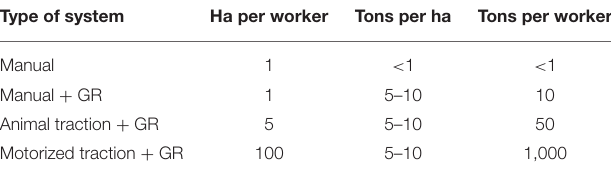
America and Oceania have the bigger proportion of farms over 100 ha (about 25 and 15%, respectively).